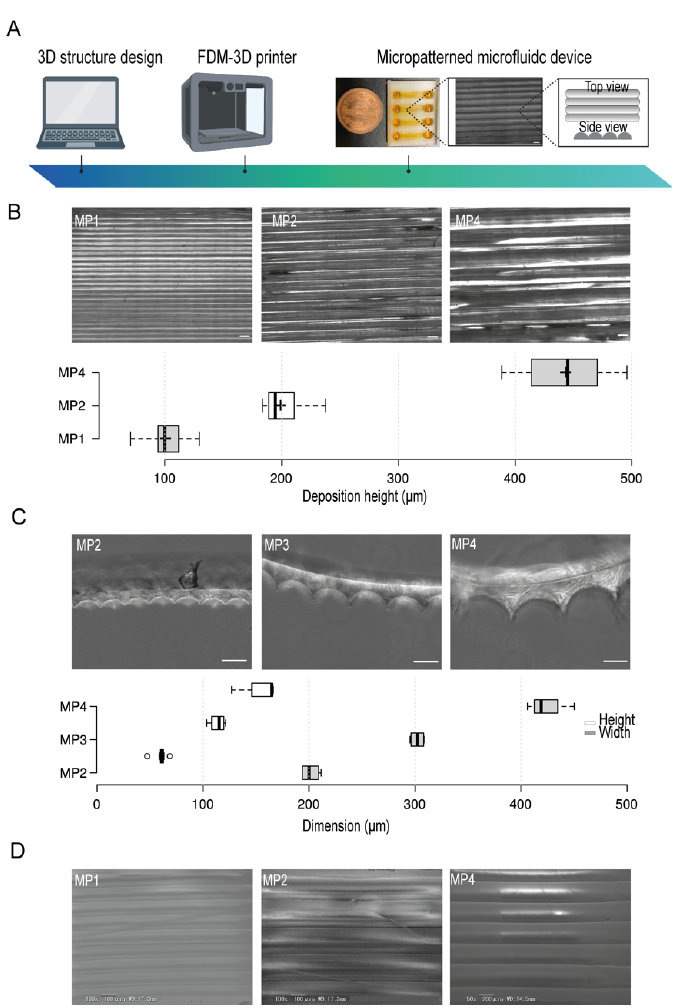
Figure 1. The conceptual design, fabrication, and micropatterns characteristics in the microfluidic devices. ( A ) An illustration of the stepwise design and fabrication of 3D-PMMD showing the mi- cropattern topography. ( B ) (Top) Bright-field images of micropatterns at different printing deposition heights of 100 µ m (MP1), 200 µ m (MP2), and 400 µ m (MP4), (Bottom) Box plot showing the actual layers deposition height measurements in the microfluidic post-3D printing; box limits indicate